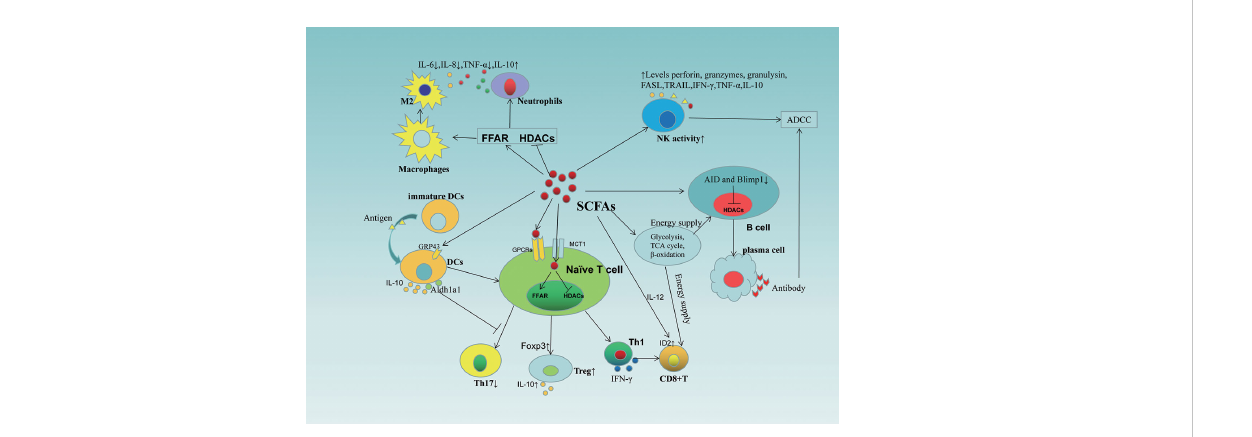
FIGURE 3 Role of SCFAs in immune cells. SCFAs affect the activity, differentiation and function of immune cells (including T cells, B cells, NK cells, DCs, macrophages, neutrophils) through different mechanisms. SCFAs, short-chain fatty acids; GPCRs, G-protein-coupled receptors; HDACs, inhibit histone deacetylases; FFAR, free fatty acid receptor; ADCC, antibody dependent cell-mediated cytotoxicity; IL, interleukins; MCT1, monocarboxylate transporters 1; FASL, Fas Ligand; TRAIL, tumour necrosis factor-related apoptosis-inducing ligand; NK, natural killer cells; DC, dendritic cell; Aldh1a1, aldehyde dehydrogenases 1 family member a1; AID, activation-induced cytidine